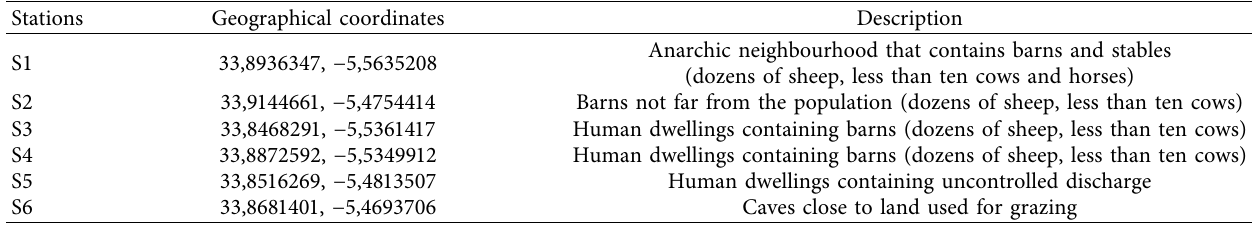
Figure 1: Study stations. Table 1: Description of study